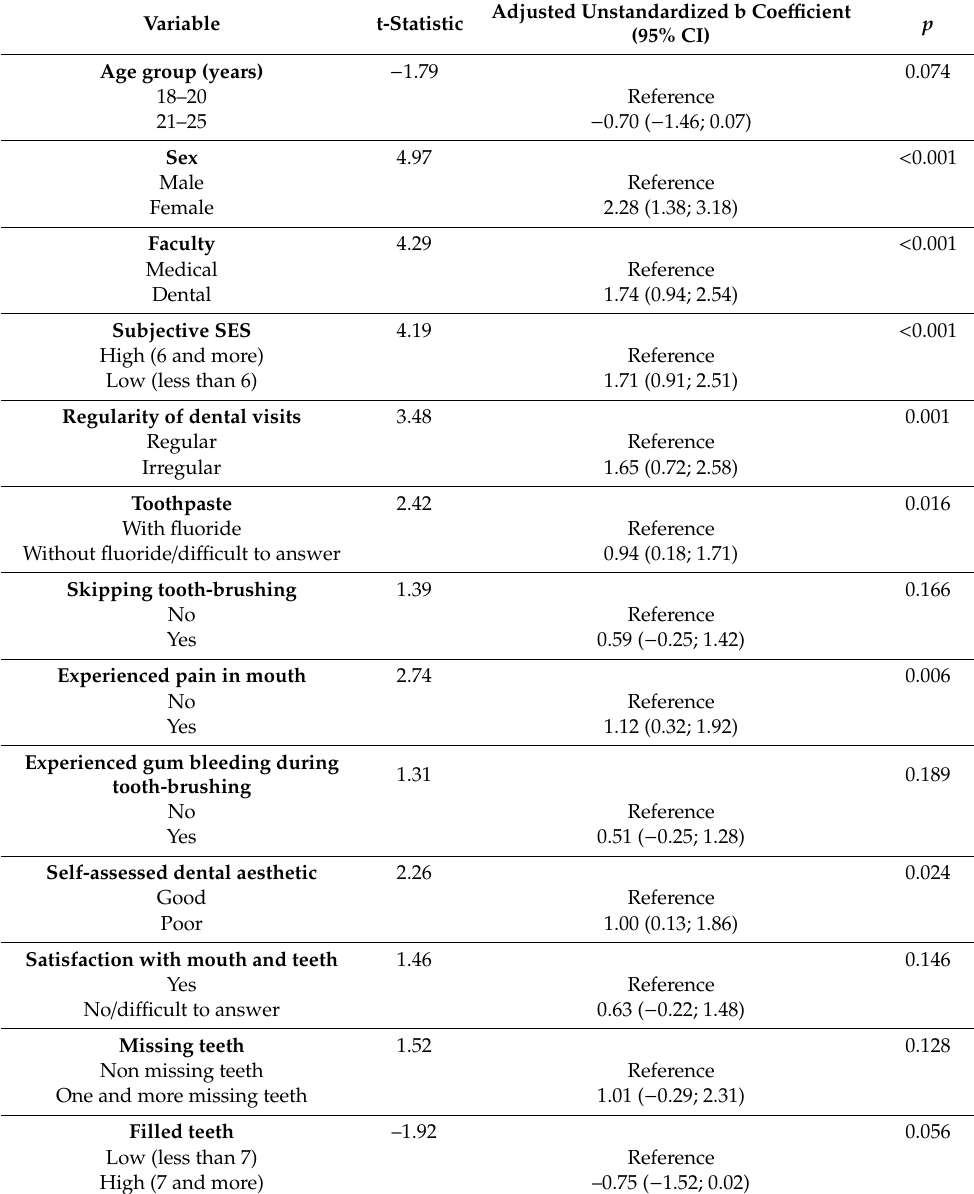
Table 5. Associations between perceived stress and selected variables in the study sample: results from multivariable linear regression 1